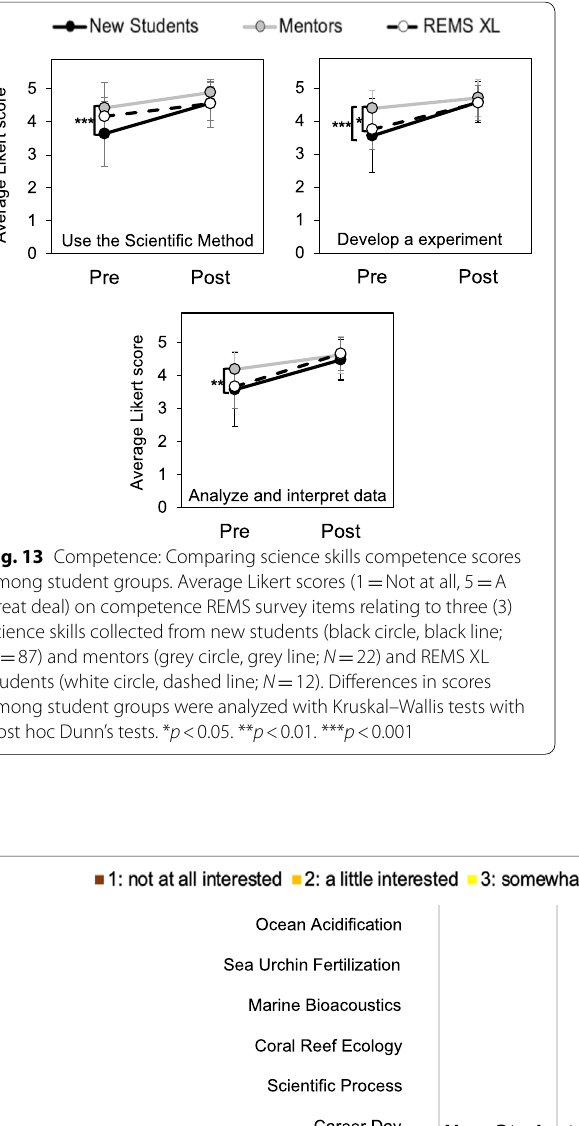
87) and mentor ( N 22) responses to REMS = =